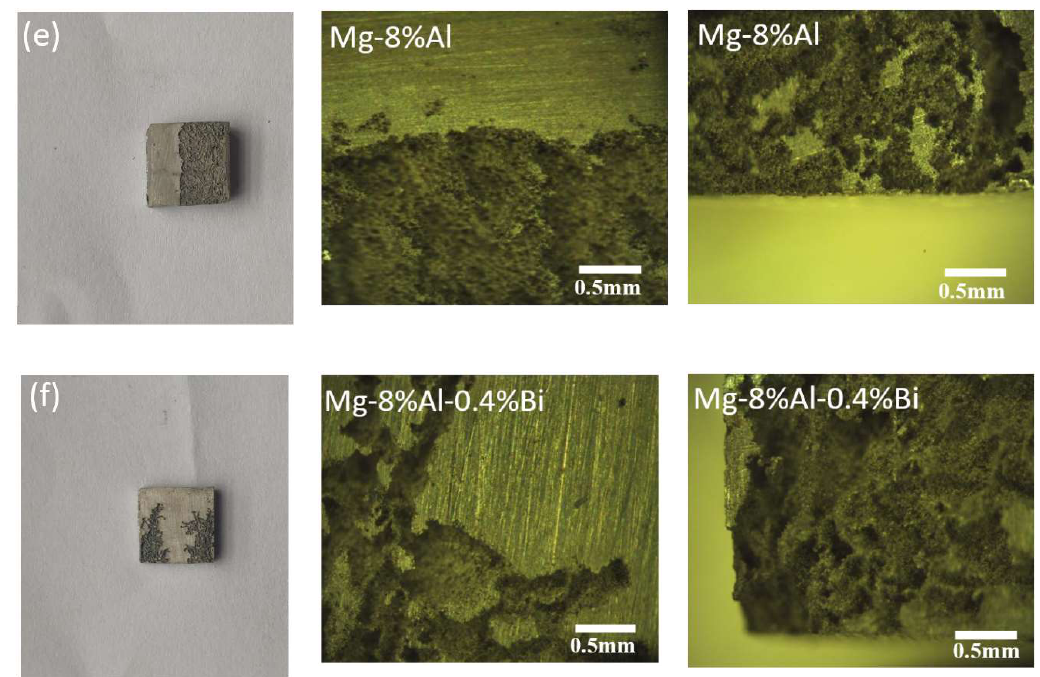
Figure 10. Metallographic microscope images of ( a ) Mg,( b ) Mg–8%Al, and ( c ) Mg–8%Al–0.4%Bi soaked in 3.5% NaCl solution for 12 h; ( d ) Mg, ( e ) Mg–8%Al, and ( f ) Mg–8%Al–0.4%Bi soaked in 3.5% NaCl solution for 24 h.